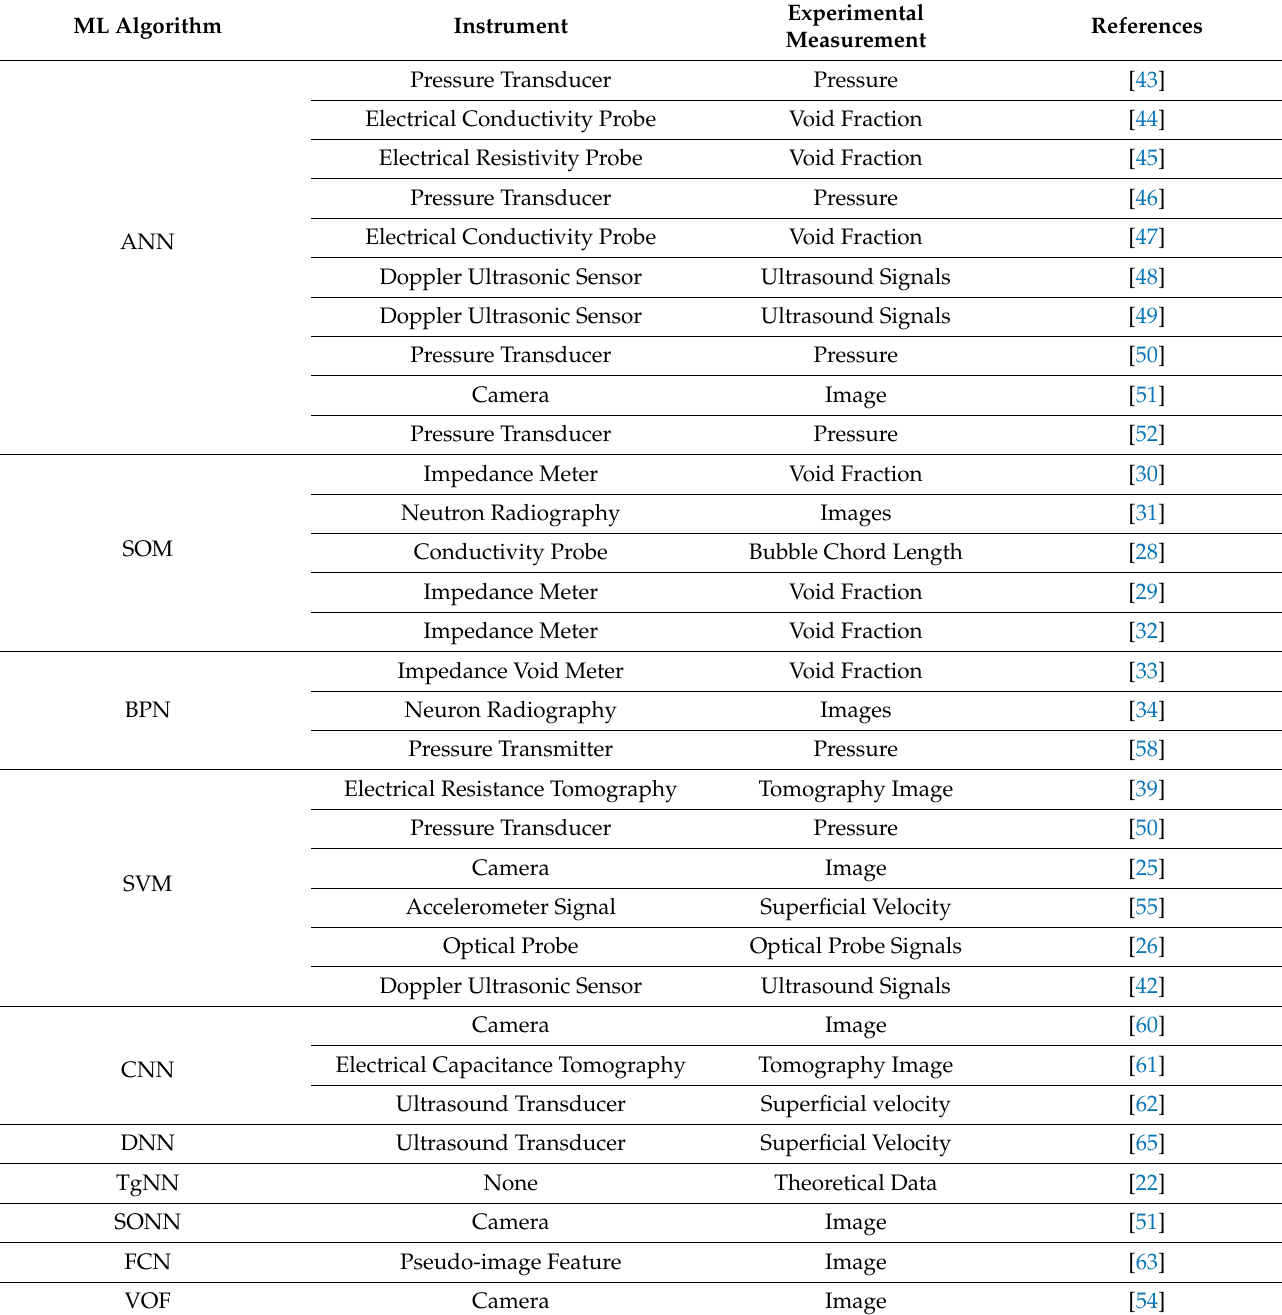
Table 1. Summary of ML applications to predict gas–liquid two-phase flow